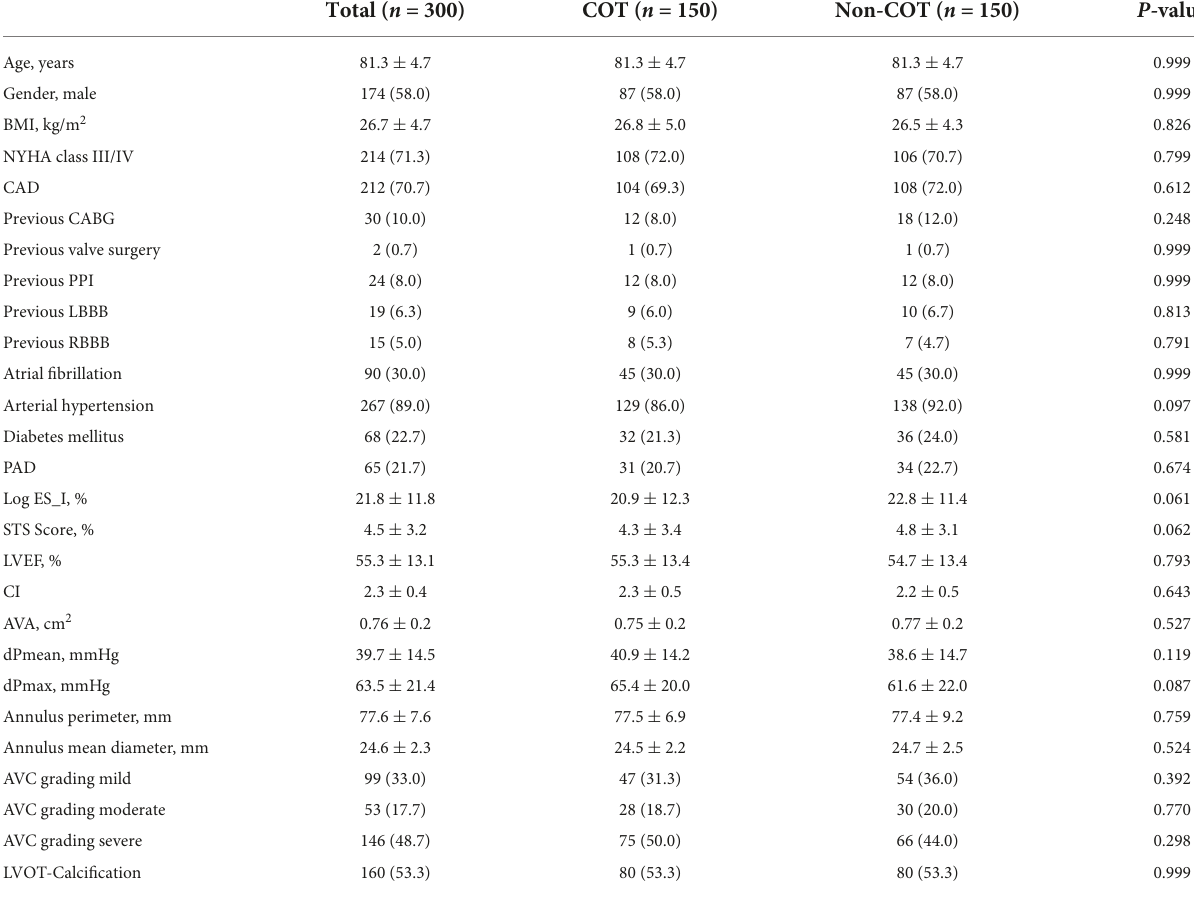
TABLE 2 Patient clinical and functional characteristics in matched